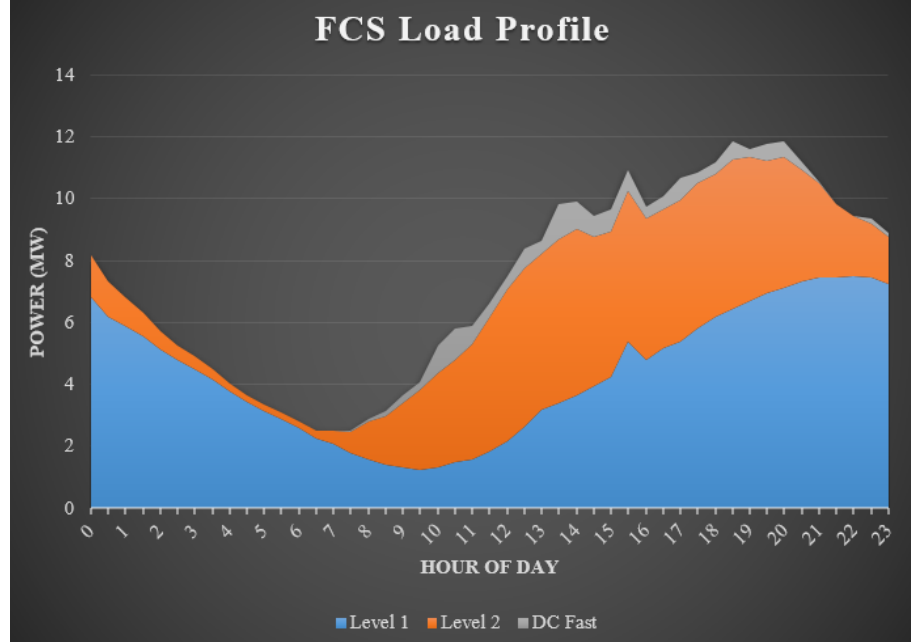
Figure 5. Hourly load profile of a typical fast charging